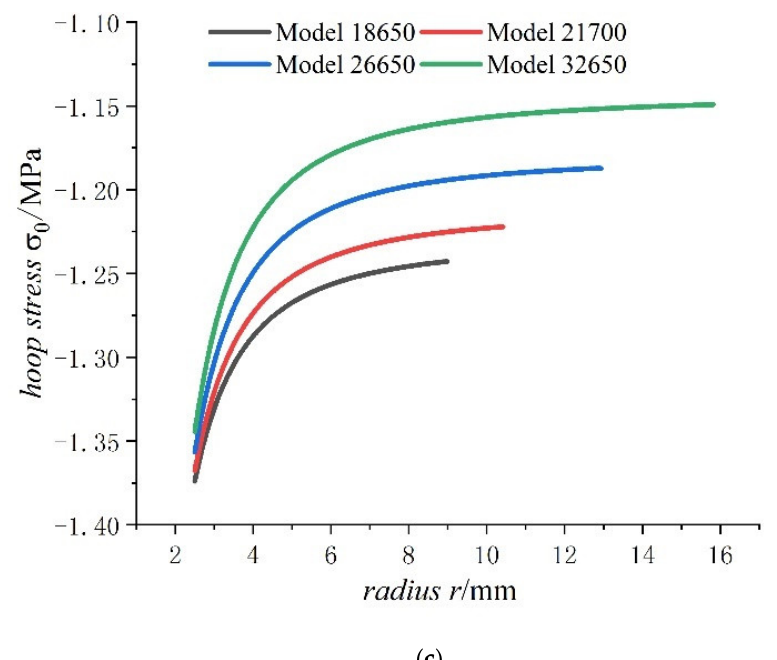
Figure 8. Displacements and stresses of jellyroll of four types of lithium-ion power batteries on a fully charged state: ( a ) displacements; ( b ) radial stresses; ( c ) hoop stresses.